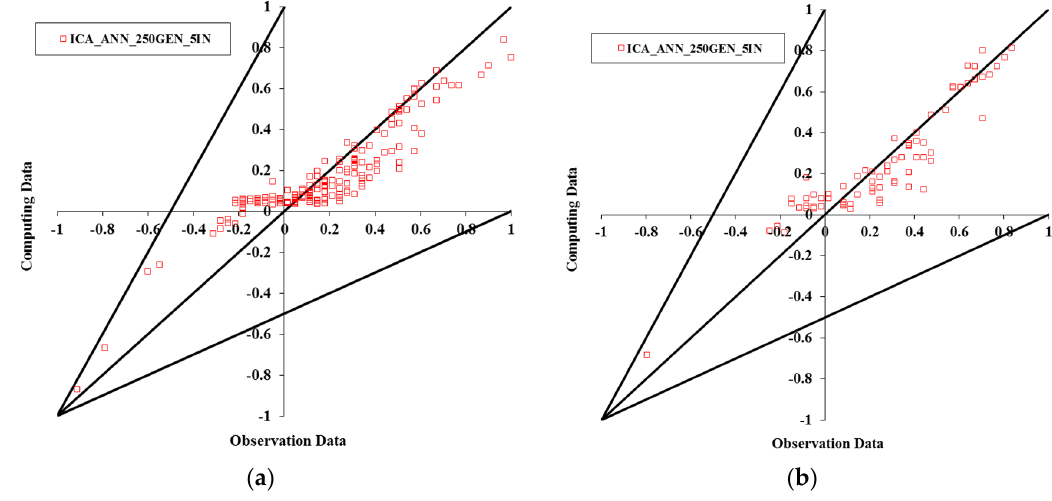
Figure 4. Results of the ICA ‐ ANN for ( a ) training and ( b ) testing. Coatings 2017 , 7 , 49